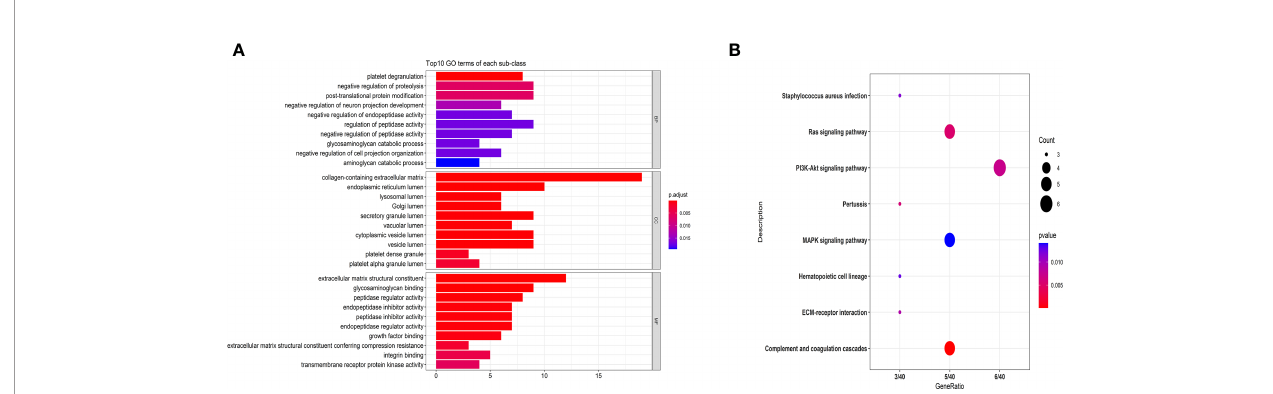
FIGURE 2 | GO (A) and KEGG pathway analyses (B) of MS-related proteins. Classi fi cation of 83 DEPs based on biological processes, molecular functions, cellular components (A) and KEGG pathways (B) . (A) The abscissa represents the number of DEPs in each functional classi fi cation. (B) The ordinate represents the signi fi cantly enriched KEGG pathway, and the abscissa represents the number of genes enriched in the KEGG pathway/total number of genes. The colors in the fi gure indicate the magnitude of the p-value. The size of the point represents the gene